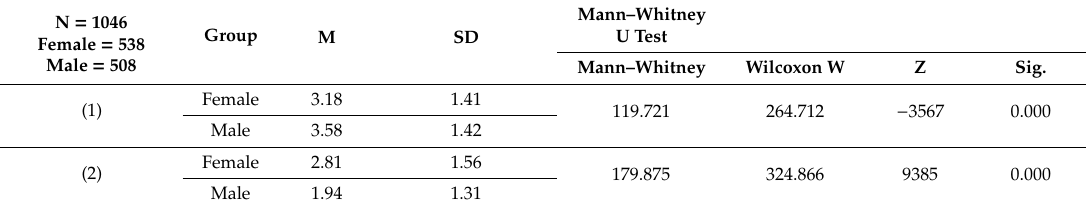
Table 8. PA practice through the autonomous format and virtual classes during the